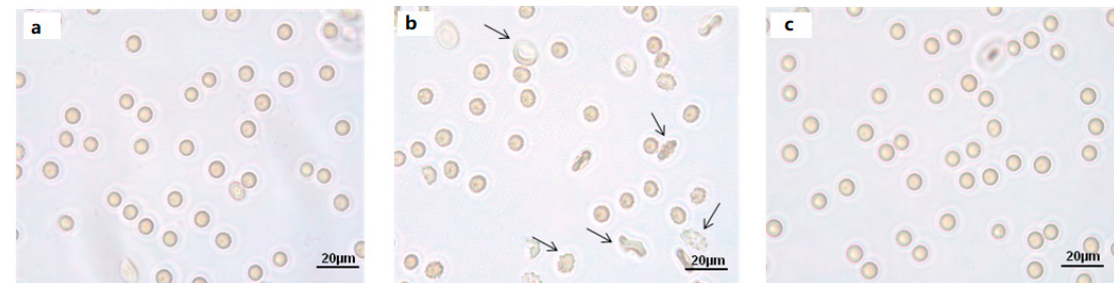
Figure 5. Light microscope observations of untreated (ctr) ( a ), 300 µ M H 2 O 2 - ( b ) and 100 µ M Mel + 300 µ M H 2 O 2 -treated erythrocytes ( c ), at 90 min of SO 4 = medium incubation. Note the significant morphological changes in b , where, 70% altered cells were